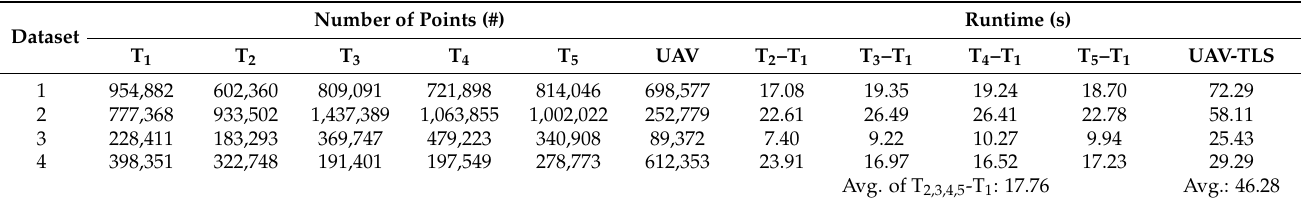
Table 5. Runtime performance of the coarse alignment step. ‘UAV-TLS’ represents the coarse alignment of the UAV data and the registered TLS data, for which the registered TLS data were merged by with all the single TLS point clouds, and the corresponding number of points is equal to the sum of the number of point in all the single TLS point clouds.